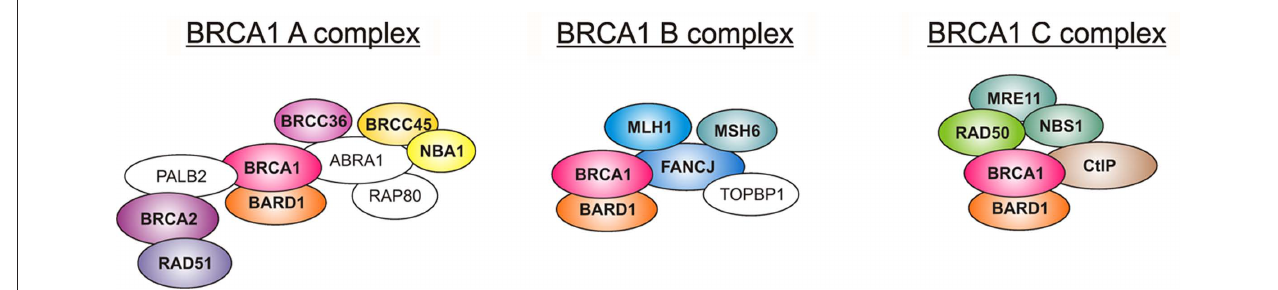
FiguRe 5 | The three BRCA1 complexes in humans. The three human complexes in which the BRCA1–BARD1 heterodimer was found are called the A, B, and C complexes. The A complex is involved in DNA repair via homologous recombination. The heterodimer is needed to load RAD51 on single-stranded DNA, where it then catalyzes the strand invasion. The B complex has a role in the G1/S cell cycle checkpoint, and the C complex is involved in the G2/M checkpoint and 5 ′ end resection, which is the initial step after a DNA double strand break. See the text for details. (Proteins with a known homolog in Arabidopsis are colored, and the names are written in bold; ABRA1, Abraxas1;